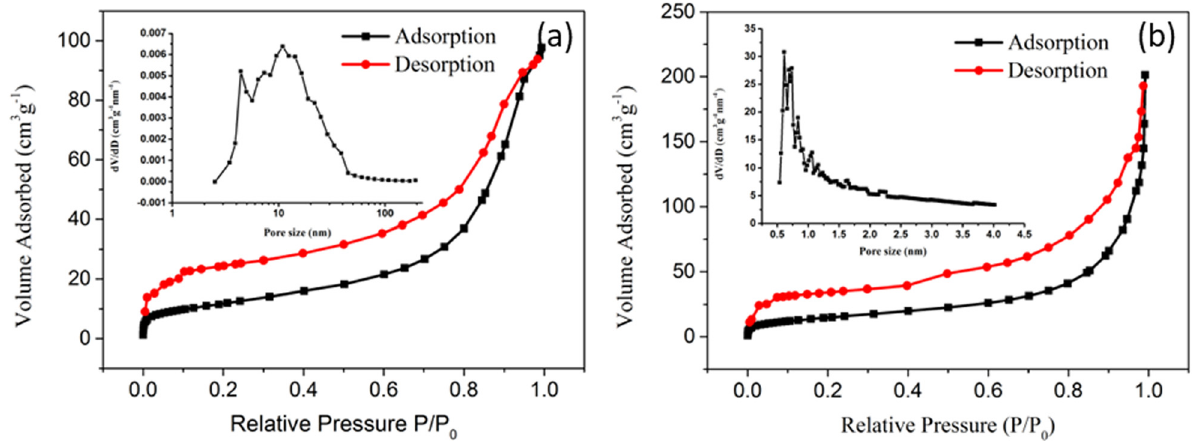
Figure 3: ( a ) N 2 - sorption - isotherms and corresponding pore - size distribution of the ( a ) Zn 0.76 Co 0.24 S@N/S - rGO and ( b ) Zn 0.76 Co 0.24 S.